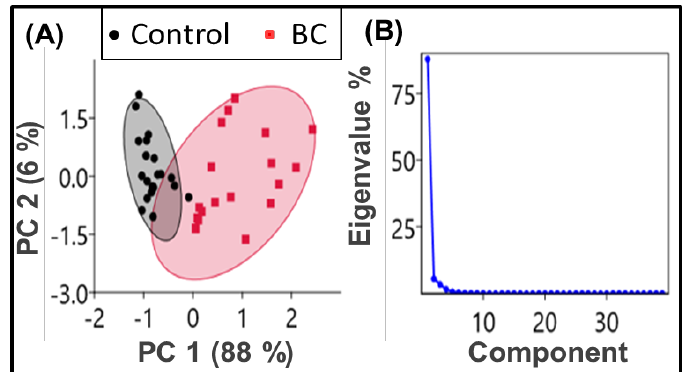
Figure 1. Principal Component Analysis (PCA) of the second derivatives curves of the FTIR absorbance spectra. ( A ) PCA scores plots (PC1 × PC2) with a 95% confidence ellipse. The data related to the control groups (black dots enclosed by a black shaded ellipse) and breast cancer (BC) (red dots surrounded by a red-shaded ellipse) are clustered together with different magnitudes and directions. ( B ) Scree plot of eigenvalues showing the percentage variance of components one and two is significant compared to the others.